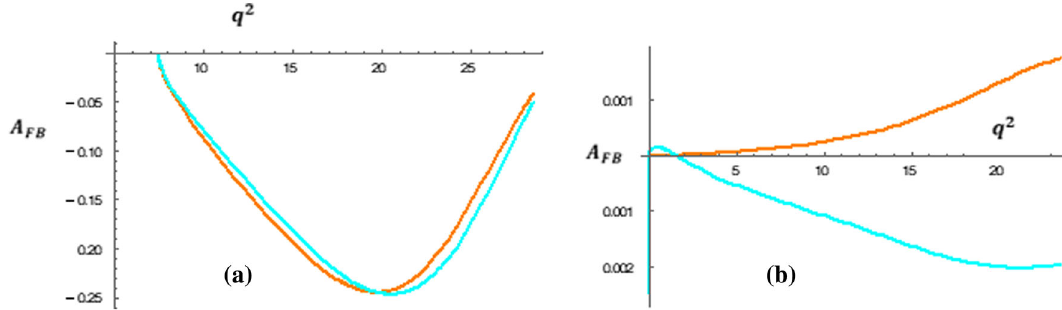
Fig. 4 a B s → ϕμ − τ + , b B s → ϕ e − μ + within allowed kinematic region of q 2 using the bound of NP couplings